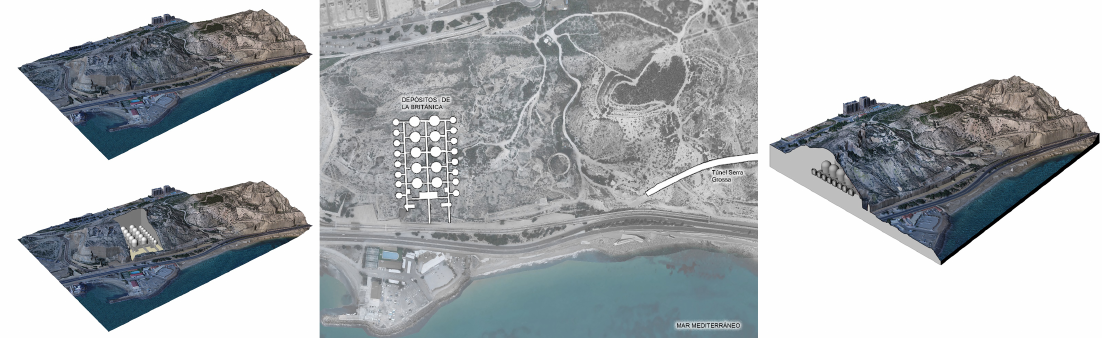
Figure 9. Image of the locations of the deposits on the Serra Grossa with a drone